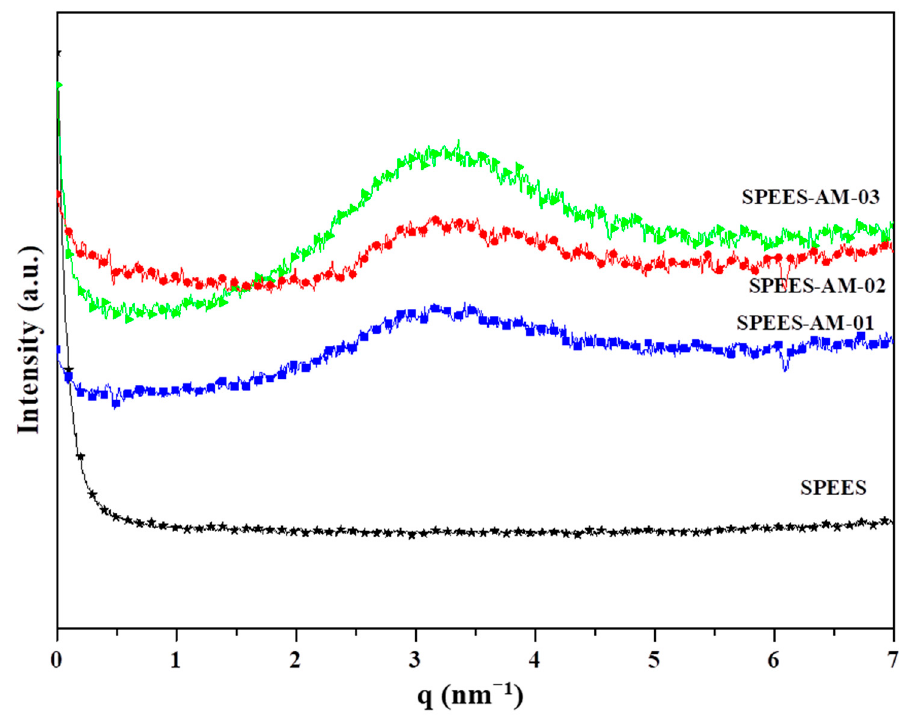
Figure 6. SAXS patterns of SPEES and SPEES- AM membranes.